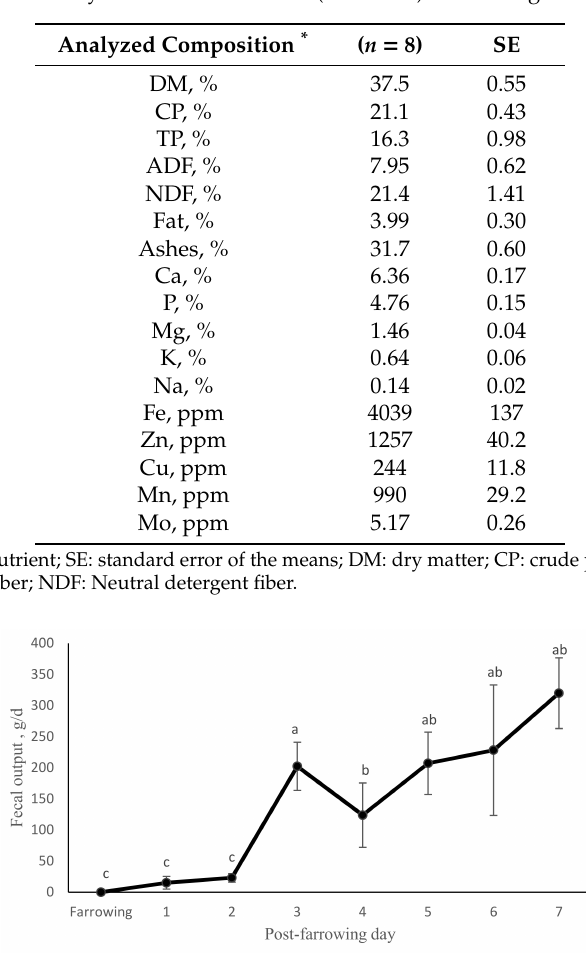
Table 3. Analyzed nutrient contents (DM basis) of lactating sow feces.